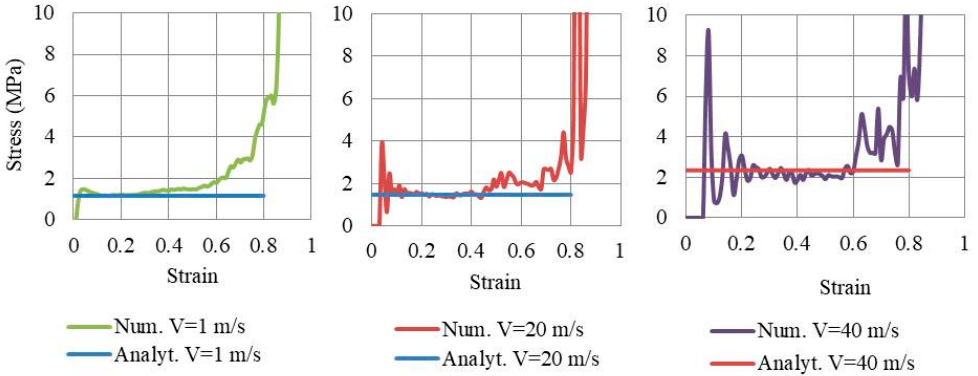
Figure 24. Numerical stress-strain curve of Aux. 1 under different impact velocities, compared to the analytical “dynamic crushing strength”.